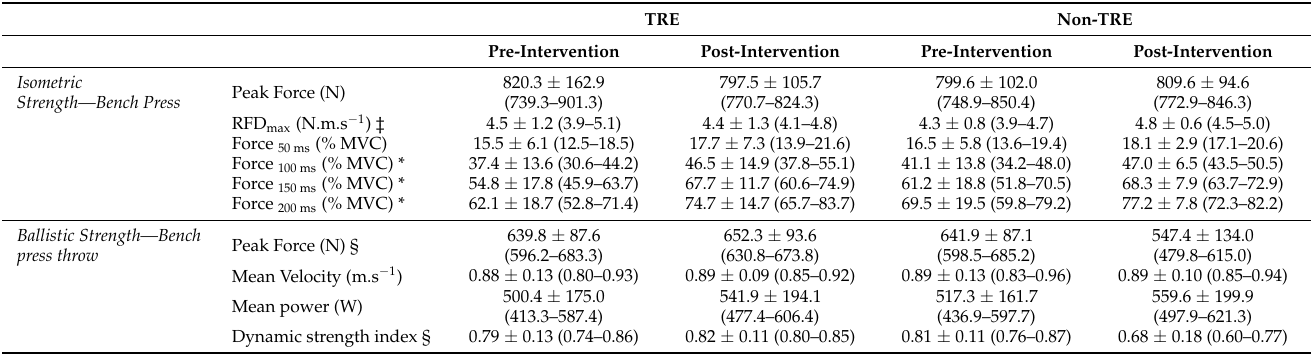
Table 4. Changes in indices of muscle strength (upper limb) after four weeks of time-restricted eating (TRE) and habitual diet